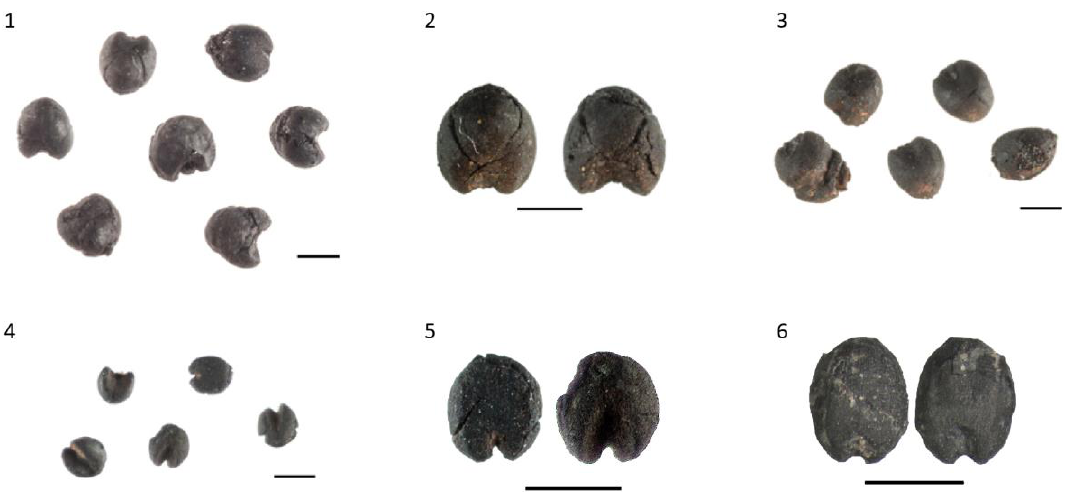
Figure 3. Millets from Cova de Punta Farisa: 1–2, Panicum miliaceum , 3, Setaria italica . Masada de Raton: 4–5, Setaria italica . Los Morrones: 6, Setaria italica .